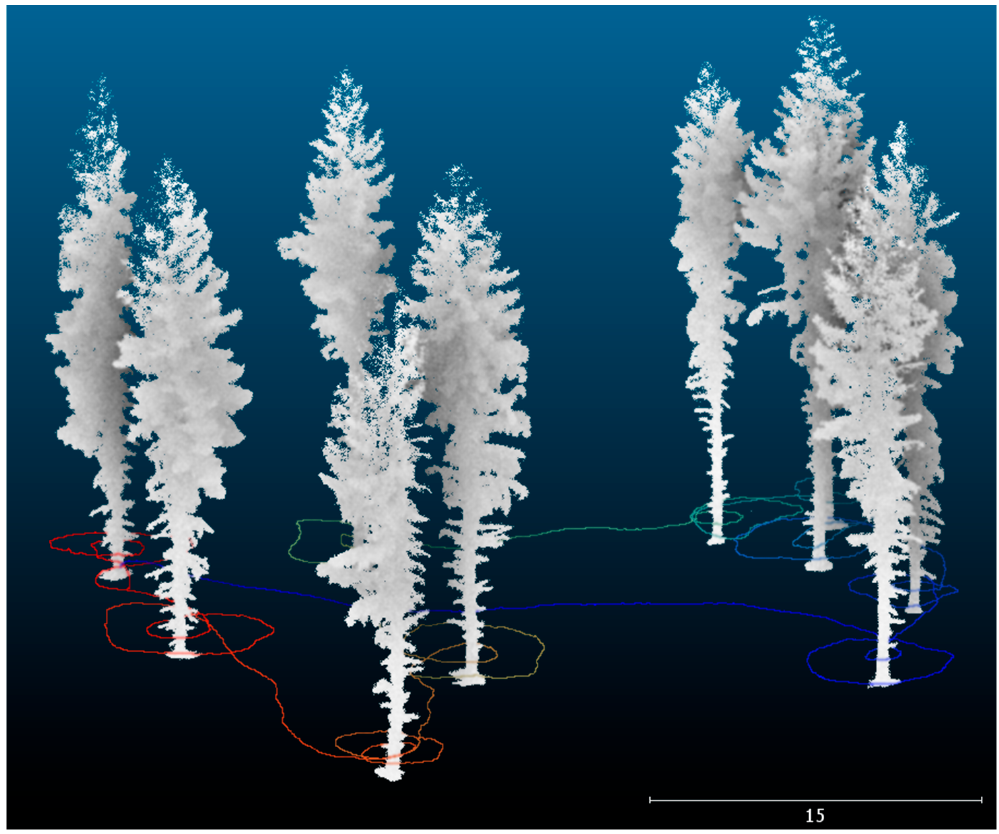
Figure 1. Shown are 10 exemplary Norway spruce trees with the corresponding trajectory consisting of two concentric circles per sample tree. Colors indicate passing minutes; the unit is equal to meter.